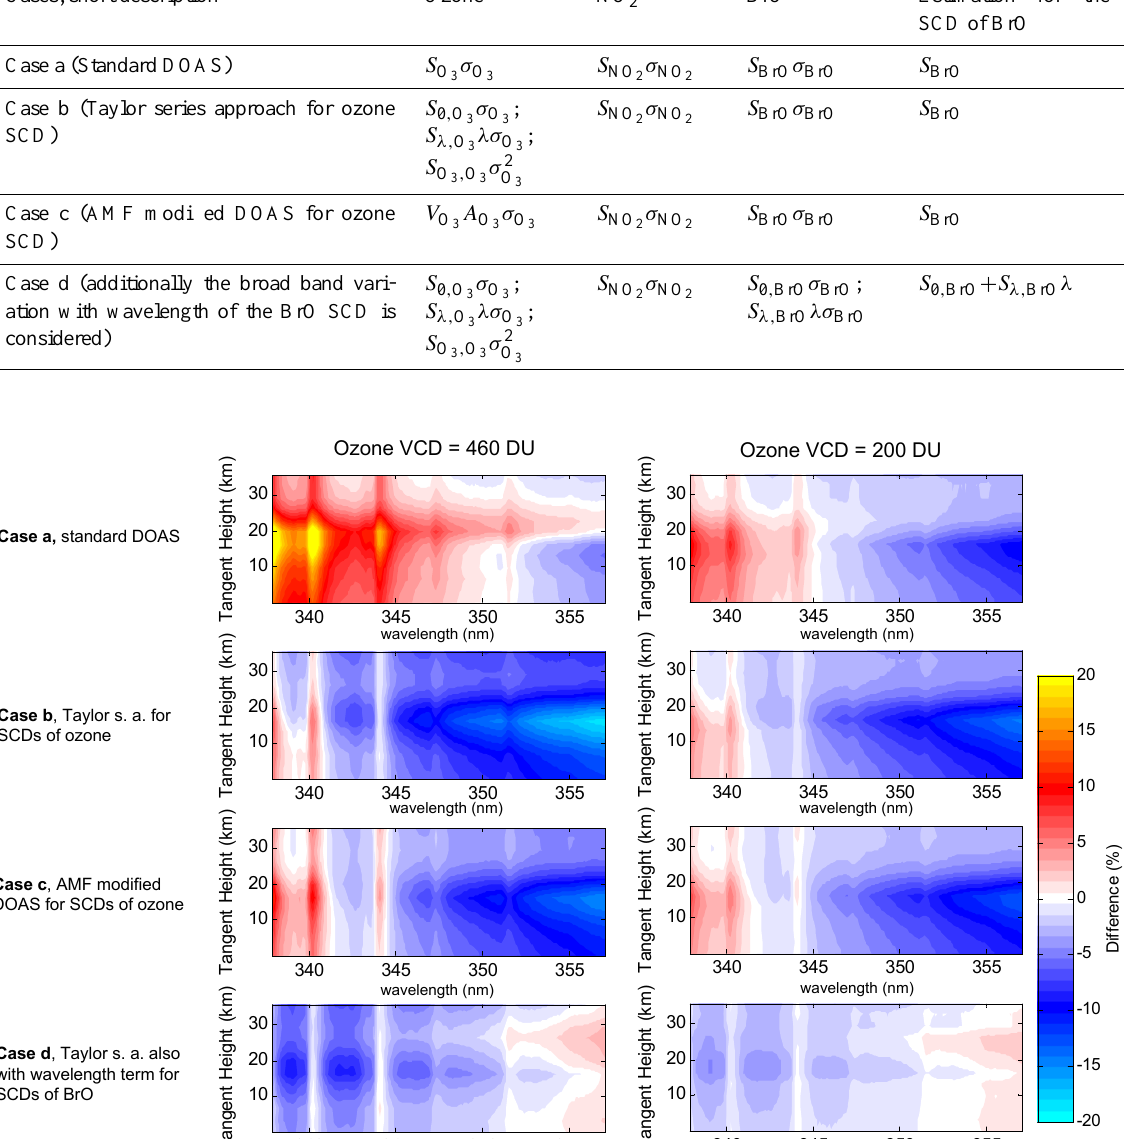
Estimation for the